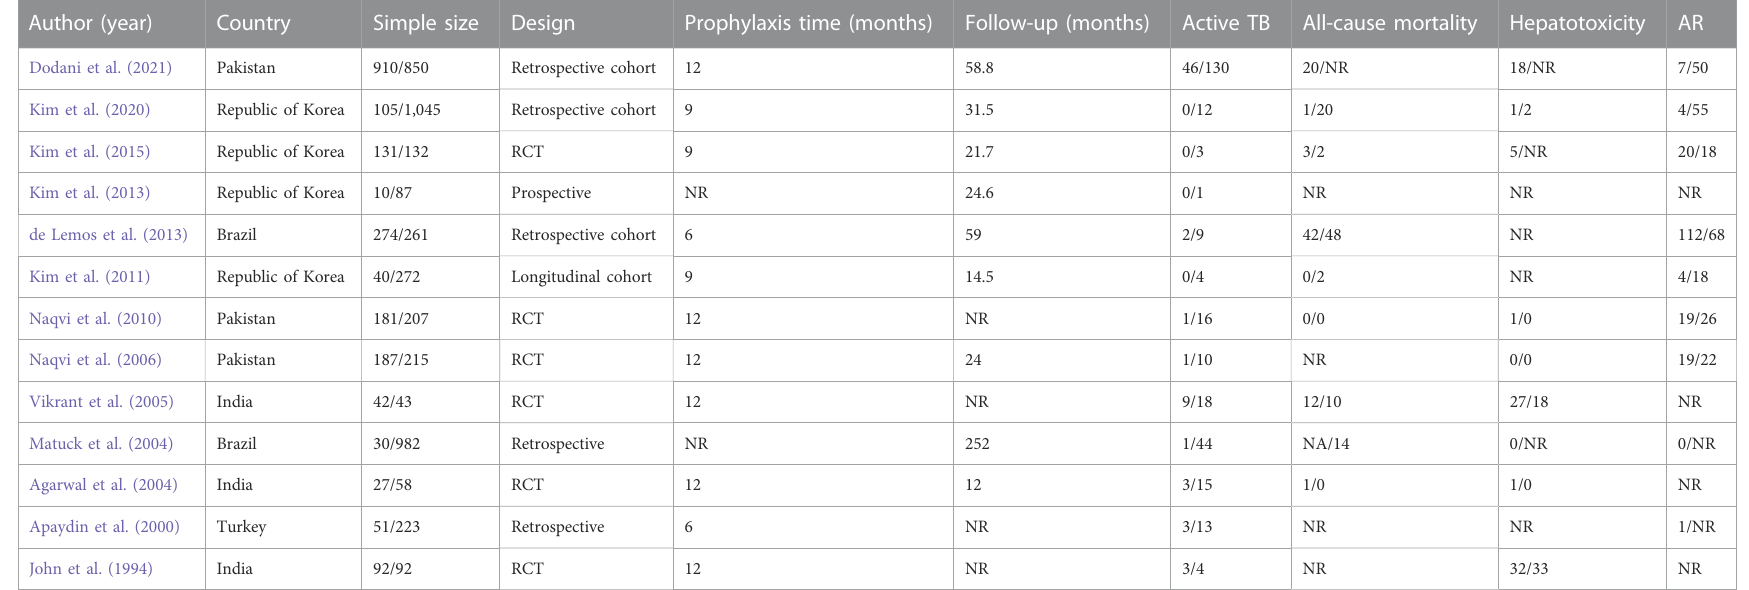
TABLE 1 Basic characteristics of included